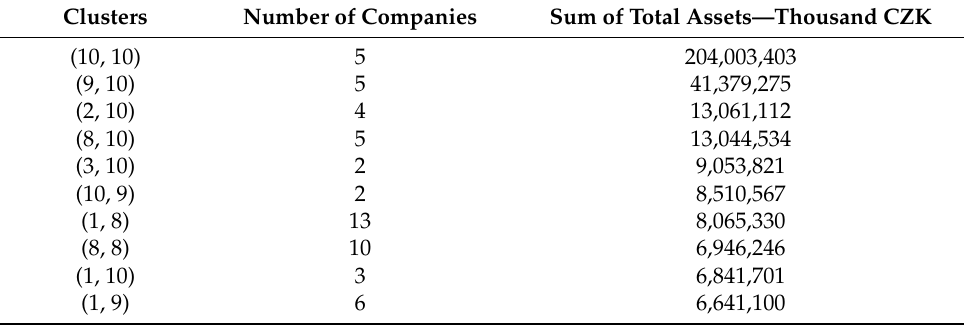
Table 10. Table of ten clusters with the highest total sum of assets for the year 2017.